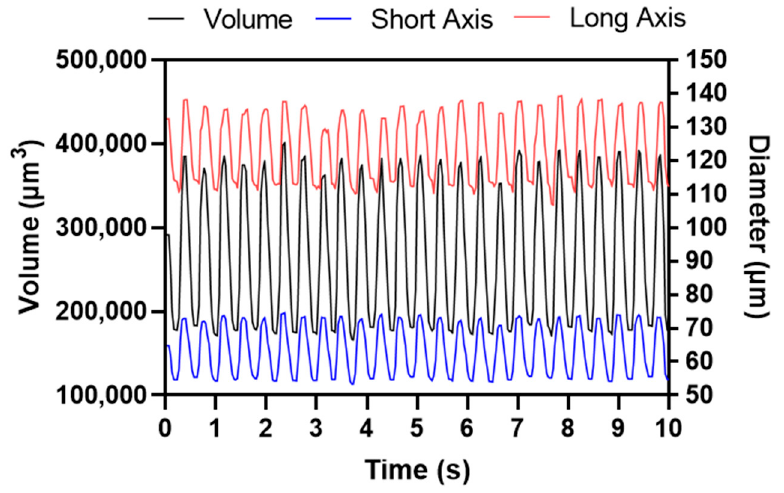
Figure A2. The volume-change peaks (black color), short axis (blue color), and long axis (red color) of heart movement generated during diastolic and systolic phases for 10 s.